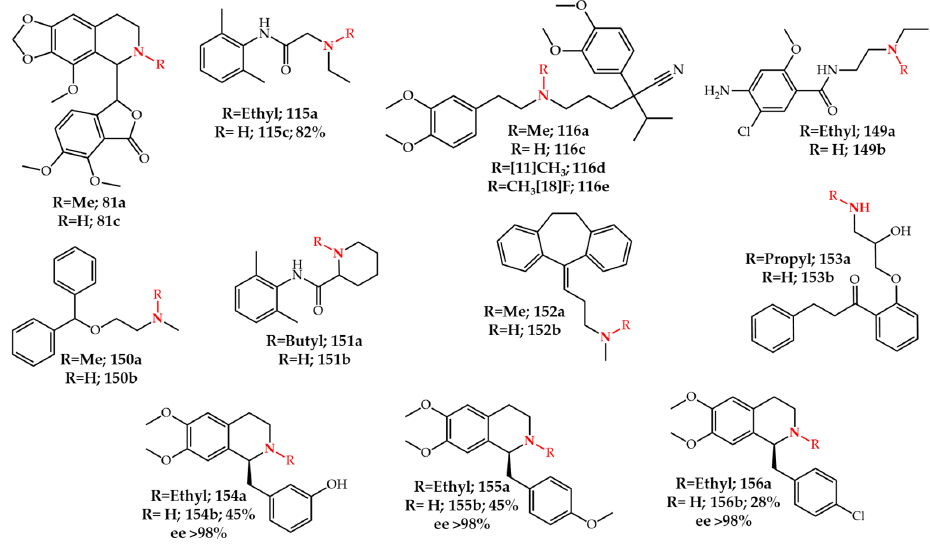
Figure 20. Examples of substrates undergoing enzymatic N ‐ dealkylation.